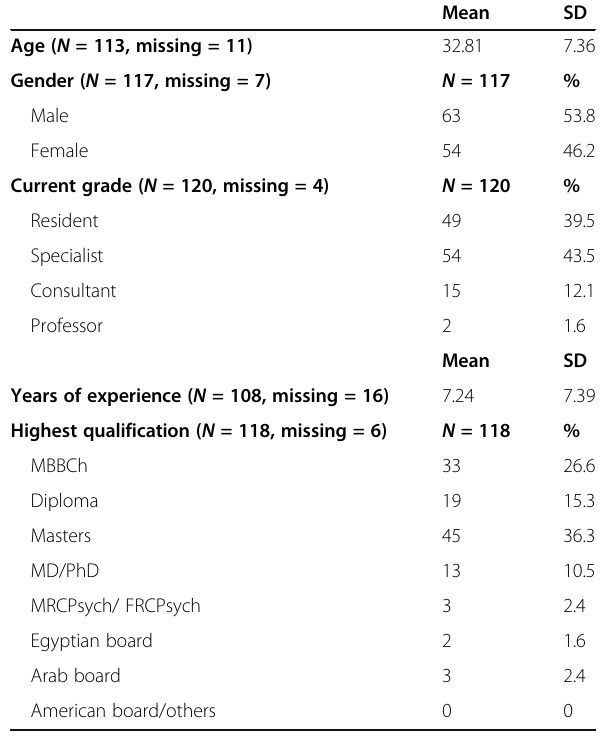
Table 1 Characteristics of the